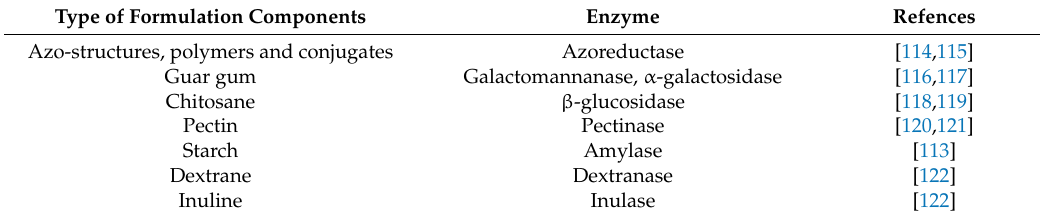
Table 3. Examples of colon bacterial enzymes used in simulated colon media for